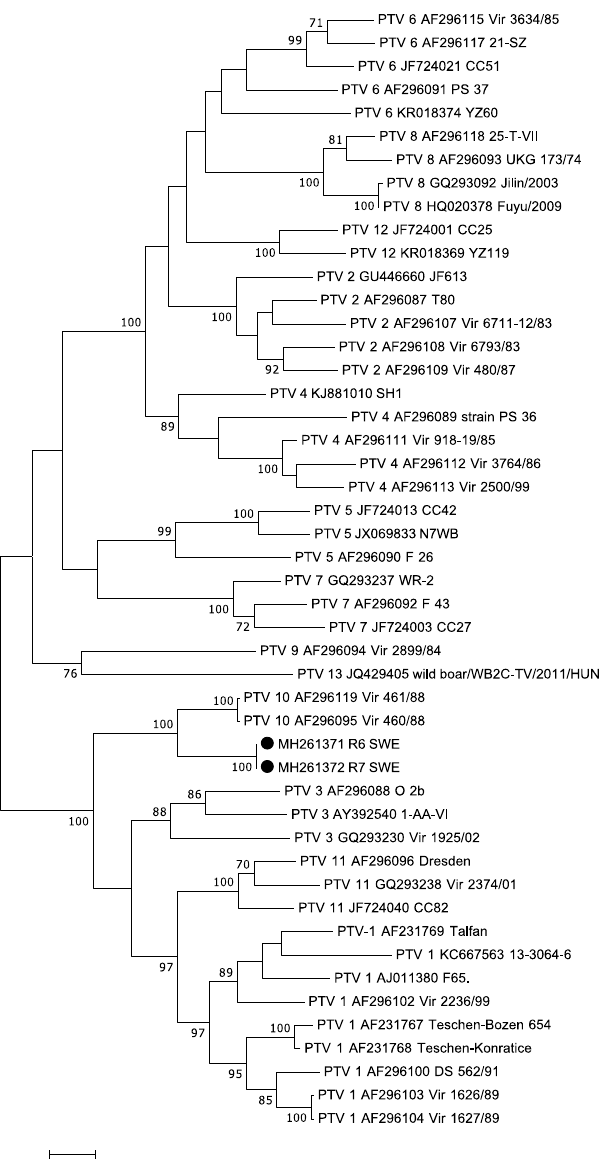
Figure 2. Phylogenetic analysis of teschoviruses. The evolutionary history was inferred by using the Maximum Likelihood method based on the Tamura Nei model with a bootstrap value of 1000. The P1 nucleotide region encoding for the capsid gene was used; in total, there were 765 nt positions in the final dataset. The teschoviruses obtained from this study are marked with black circles, and only bootstrap values greater than 70% are shown.